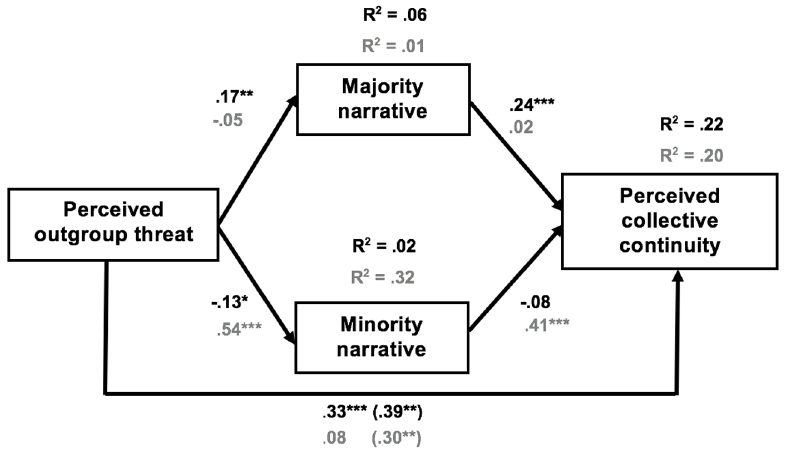
Figure 2. Path model results for Greek Cypriots (Majority, in black) and Turkish Cypriots (Minority, in grey). Note. Influence of perceived outgroup threat on perceived collective continuity, via endorsement of majority and minority historical narratives. Path-coefficients are standardized estimates and the path coefficient in brackets reflects the standardized total